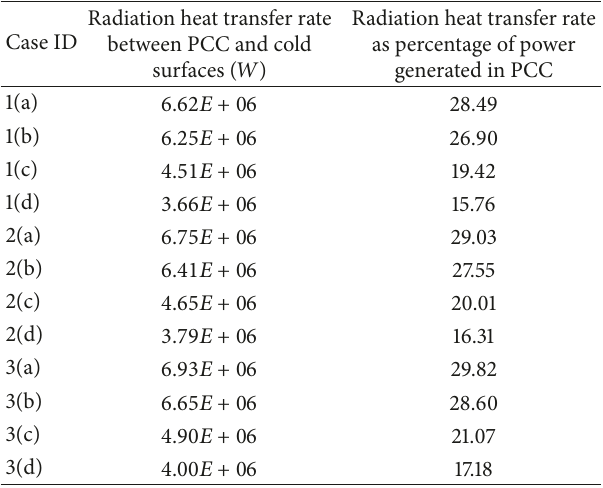
Table 13: Radiation heat transfer rates from PCC to cold